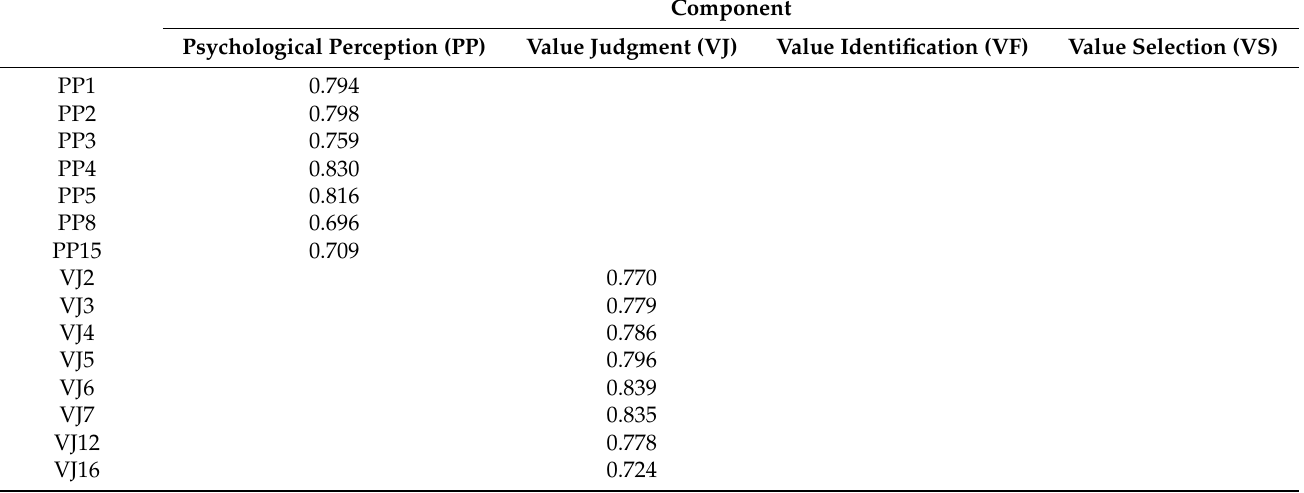
Table 2. The orthogonal rotation component matrix of the